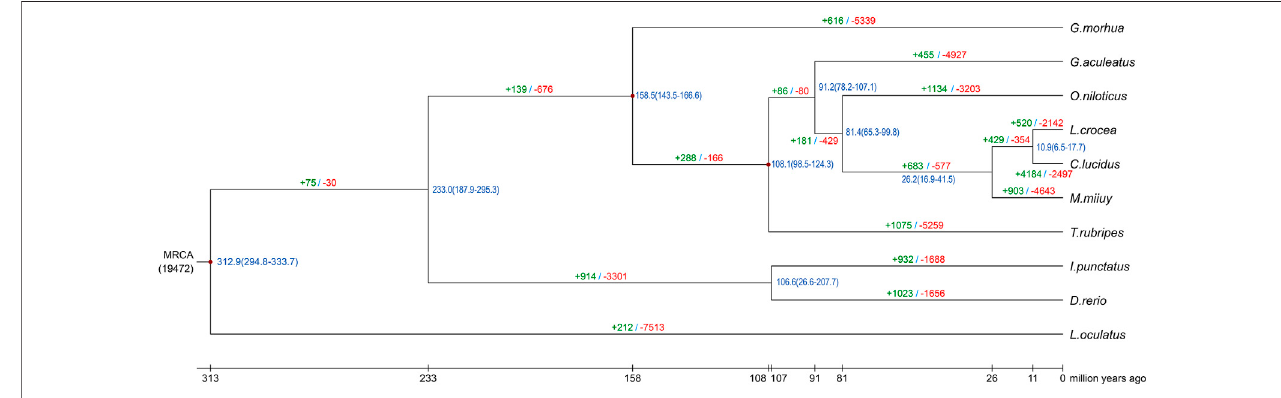
FIGURE 2 | Evolution analysis of spiny head croaker. Green and red numbers on the branches represent the expansion and contraction gene families in each species, blue numbers on the branches show the estimated divergence times in Mya, and dark red points represent the calibration time from TimeTree.